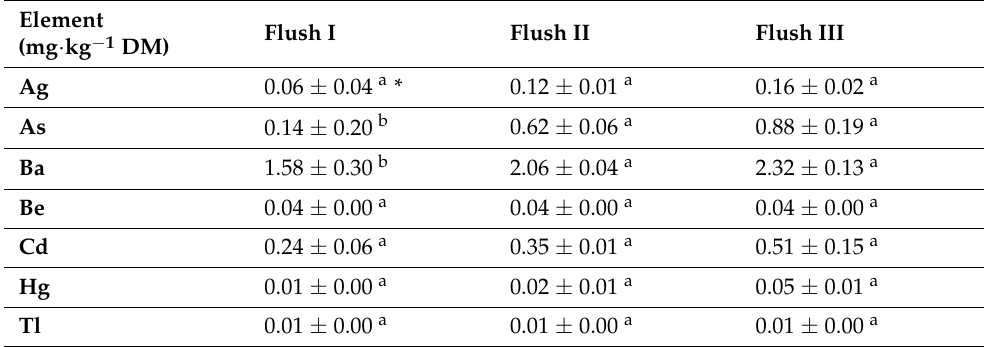
Table 5. Concentrations of TEWDHE in the fruiting bodies of P. djamor cultivated on